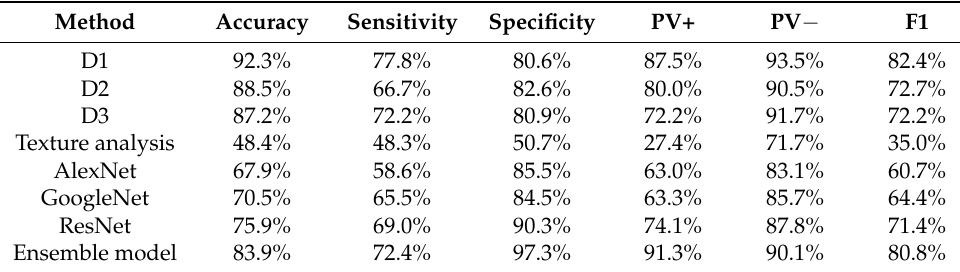
Table 4. Performances of dermatologists and automated methods on test set